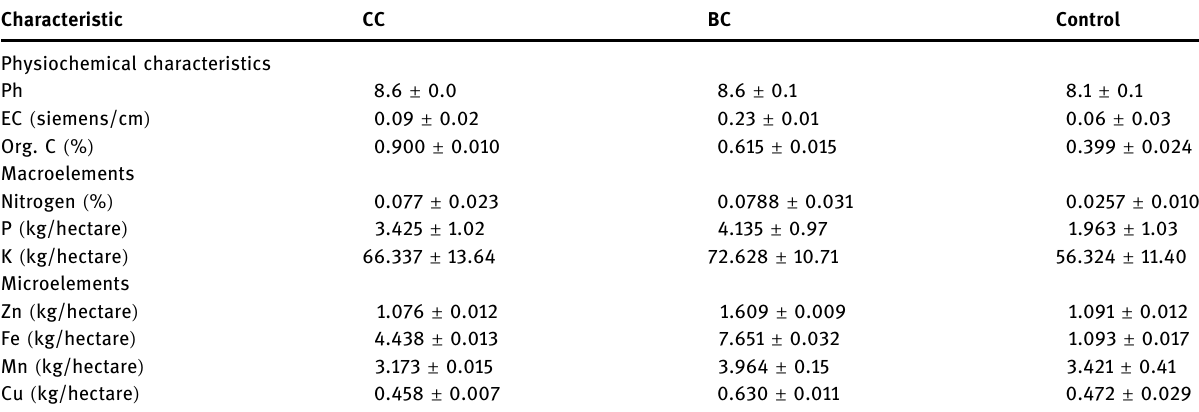
Table 7: Analysis of physiochemical, macro and micronutrients of rhizosphere soil samples in open fi eld